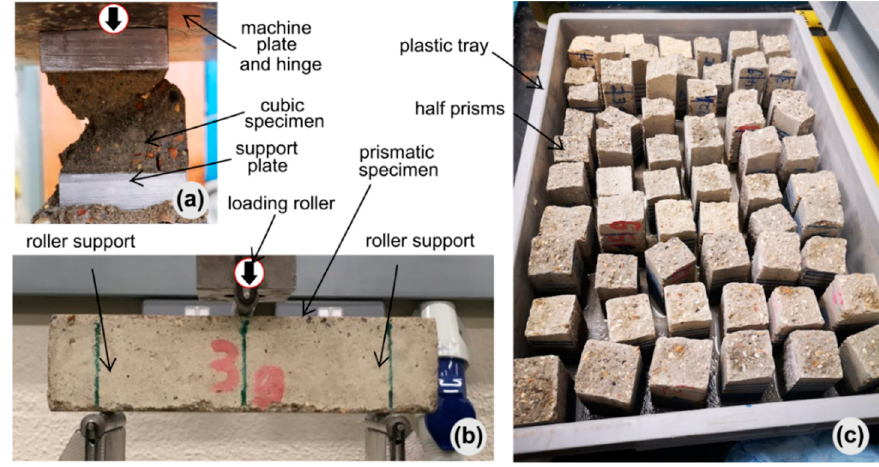
Figure 2. Methodology: ( a ) compression tests, ( b ) flexural tests, ( c ) capillary